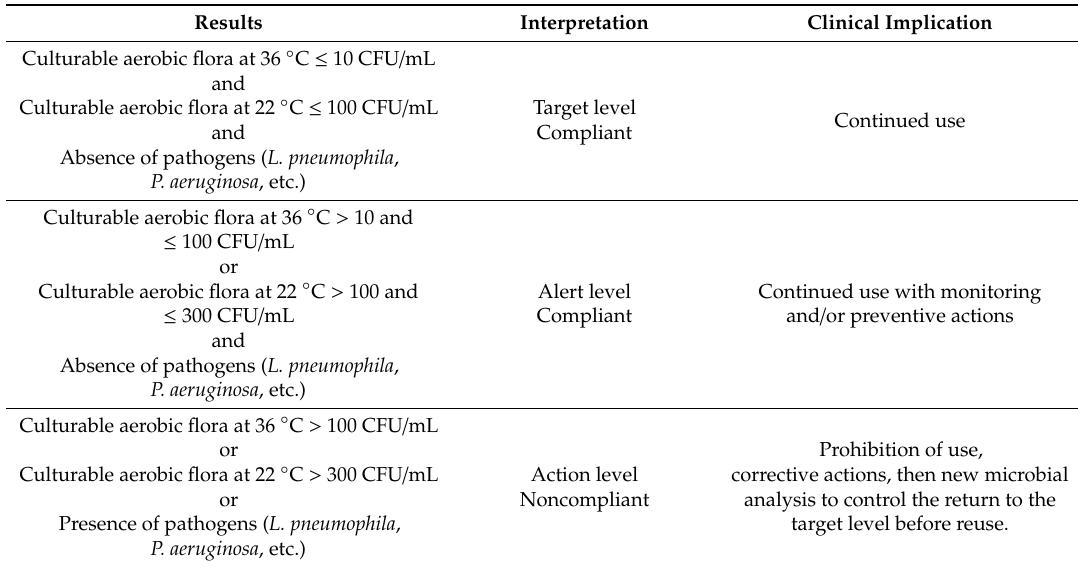
Table 1. Interpreting the results of dental unit microbial